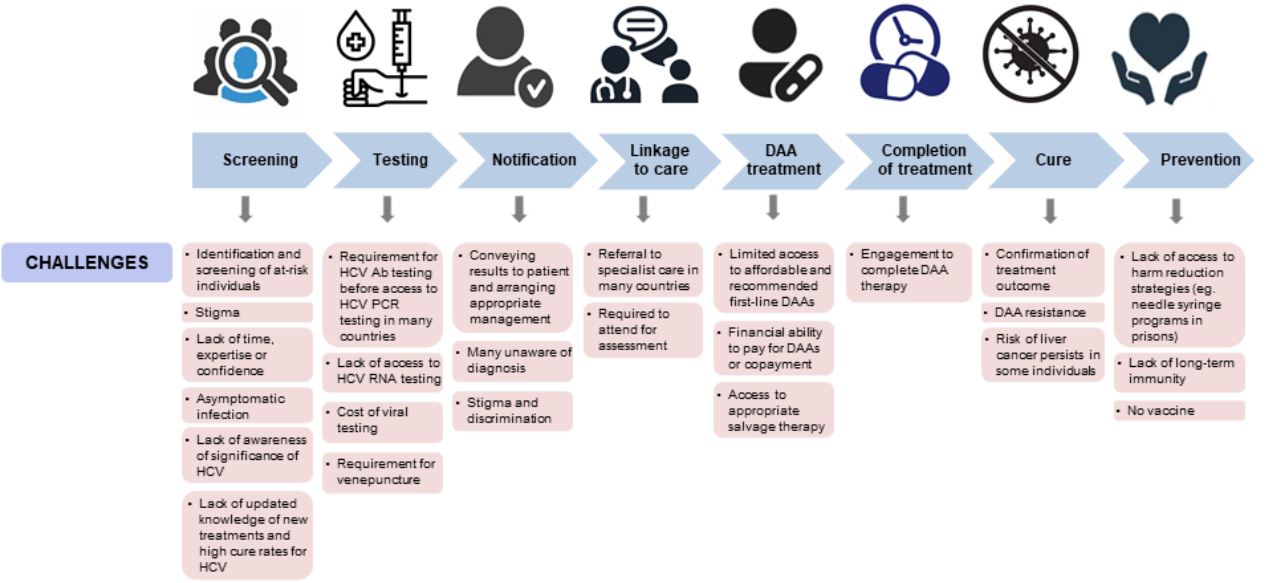
Figure 1. Current challenges in hepatitis C care. DAA = direct acting antivirals; HCV = hepatitis C virus; Ab = antibody; PCR = polymerase chain reaction; RNA = ribonucleic acid.